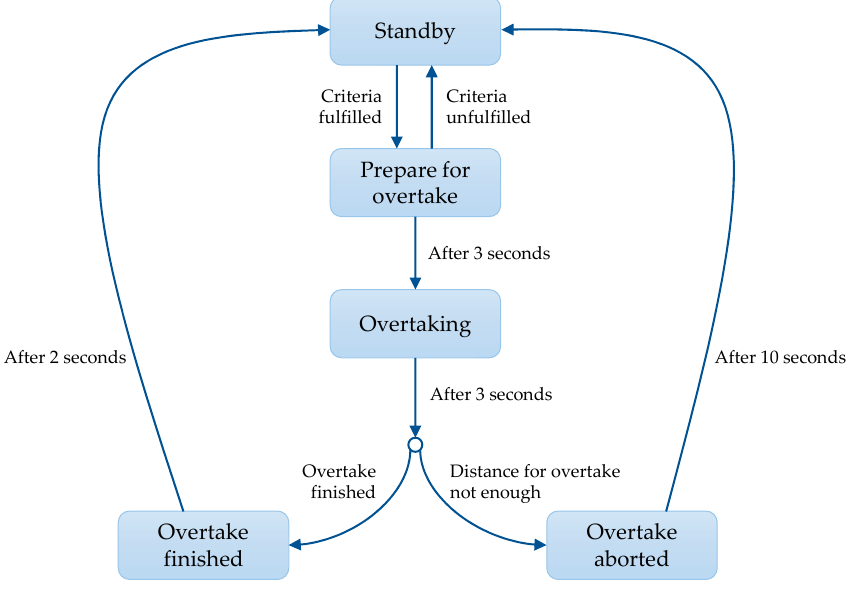
Figure 12. Overtaking logic state diagram.